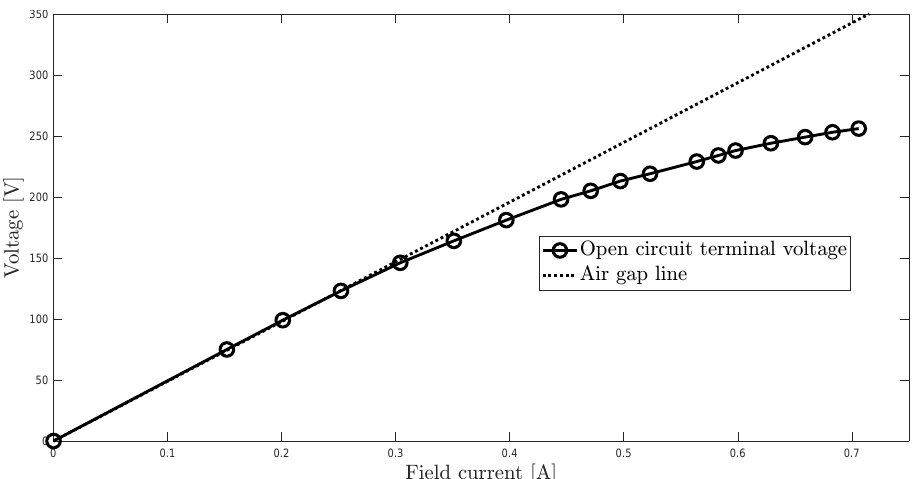
Figure 4. Open circuit characteristics and air gap line of the synchronous machine under consideration.